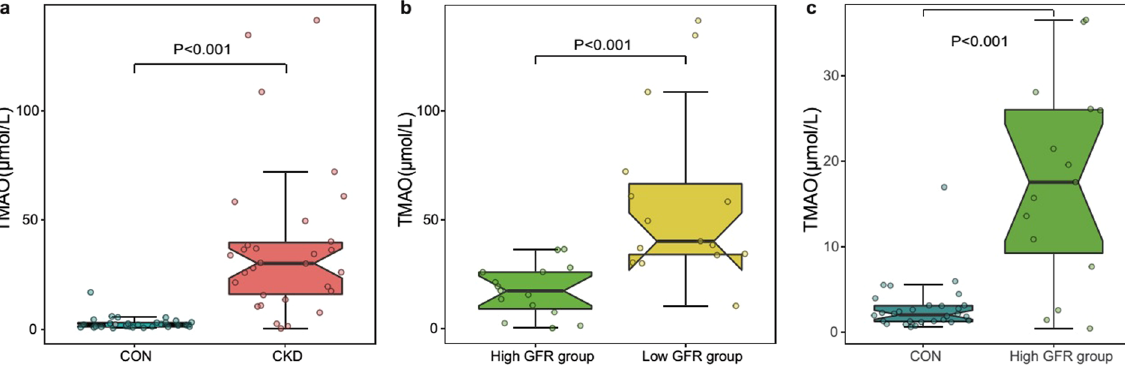
Figure 1. CKD patients showed significantly elevated plasma TMAO concentrations. ( a ) Comparison of plasma TMAO levels between the CKD patient group and the control group. ( b ) Comparison of plasma TMAO levels between the high GFR group (GFR ≥ 7 ml/min/1.73 m 2 ) and the low GFR group (GFR < 7 ml/ min/1.73 m 2 ). ( c ) Comparison of plasma TMAO levels between the high GFR group (GFR ≥ 7 ml/min/1.73 m 2 ) and the control group. TMAO, trimethylamine N-oxide; CKD, chronic kidney disease; GFR, glomerular filtration rate. The results are based on a Mann-Whitney U test of the TMAO concentrations.